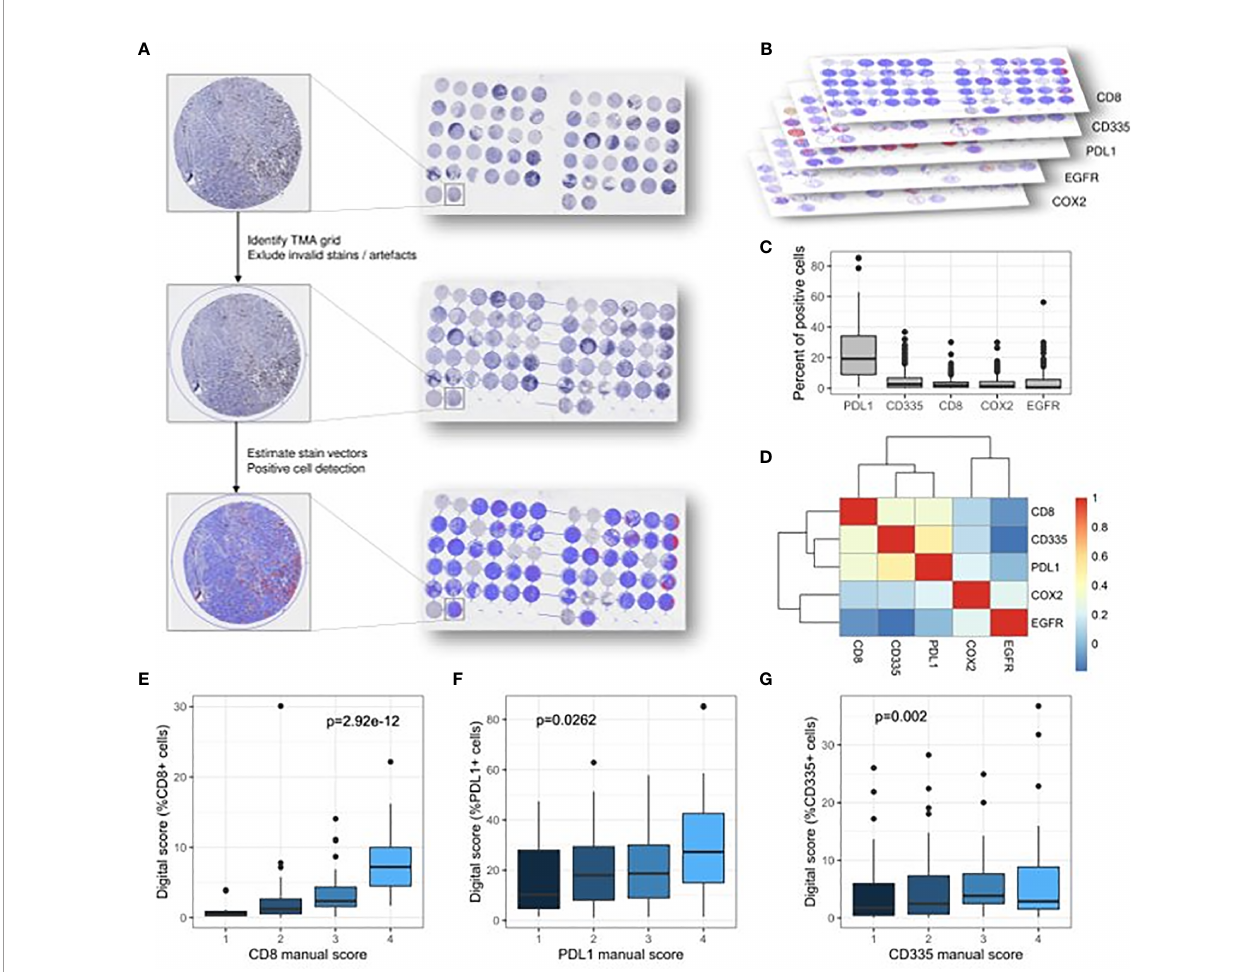
FIGURE 1 | Graphical abstract of the digital scoring procedure principles and the associations between score values obtained by different scoring techniques. (A) Identi fi cation and evaluation of tissue spots. Detection and quanti fi cation of stains. (B) Different biomarkers included in the analysis (CD8 cells, CD335/NK cells, PD-L1, EGFR, COX-2). (C) Percentage of positive cells for each stain across the samples. (D) Heatmap depicting the Spearman ’ s correlation coef fi cient between different biomarkers. (E – G) Concordance between the classical manual scoring and the digital scoring technique for CD8 cells, CD335/NK cells and